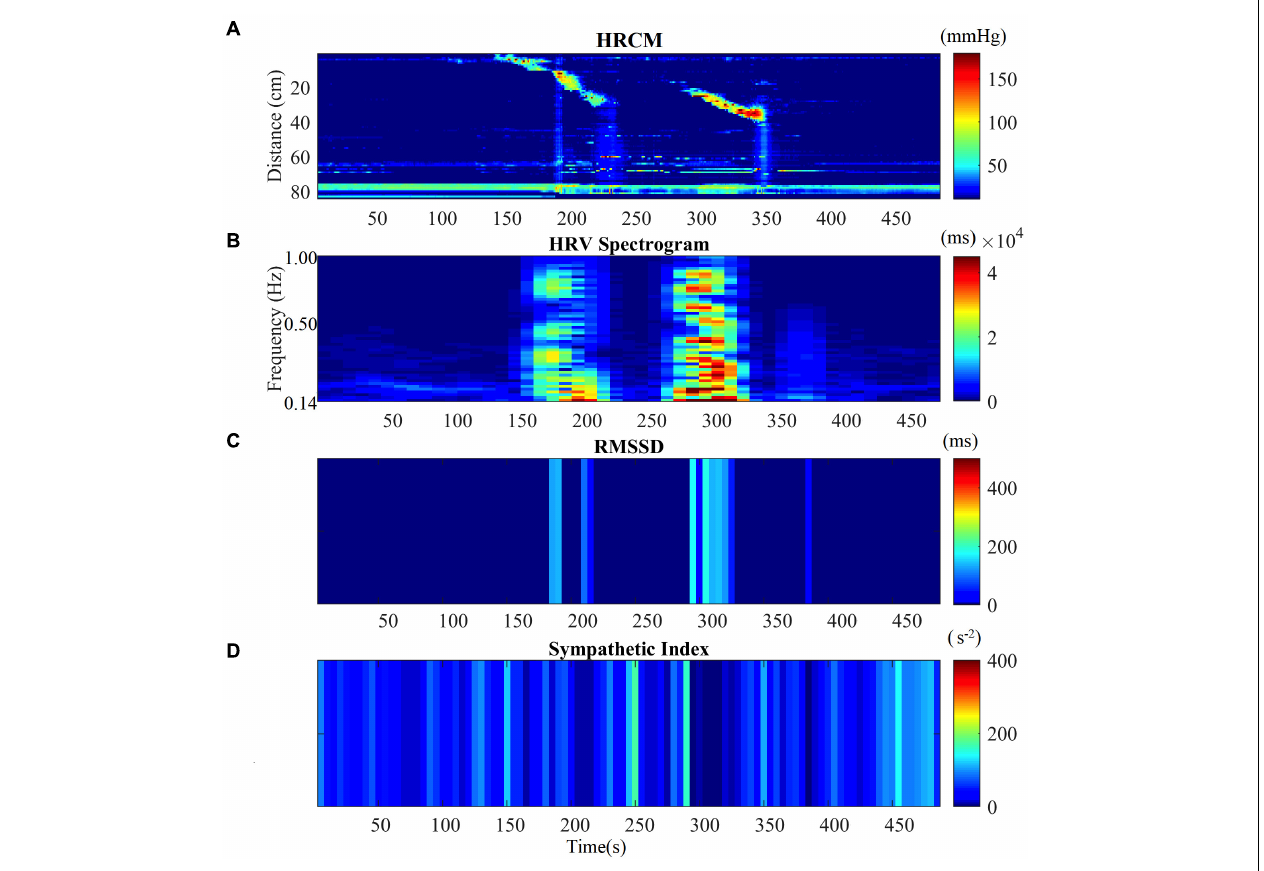
FIGURE 2 | HRV parameters associated with two consecutive HAPWs. (A) Before-During and After a Motor Complex. (B) Time matched HF Power/RSA band of the HRV signal before-during and after MC. (C) RMSSD time matched with HRCM. (D) SI time matched with